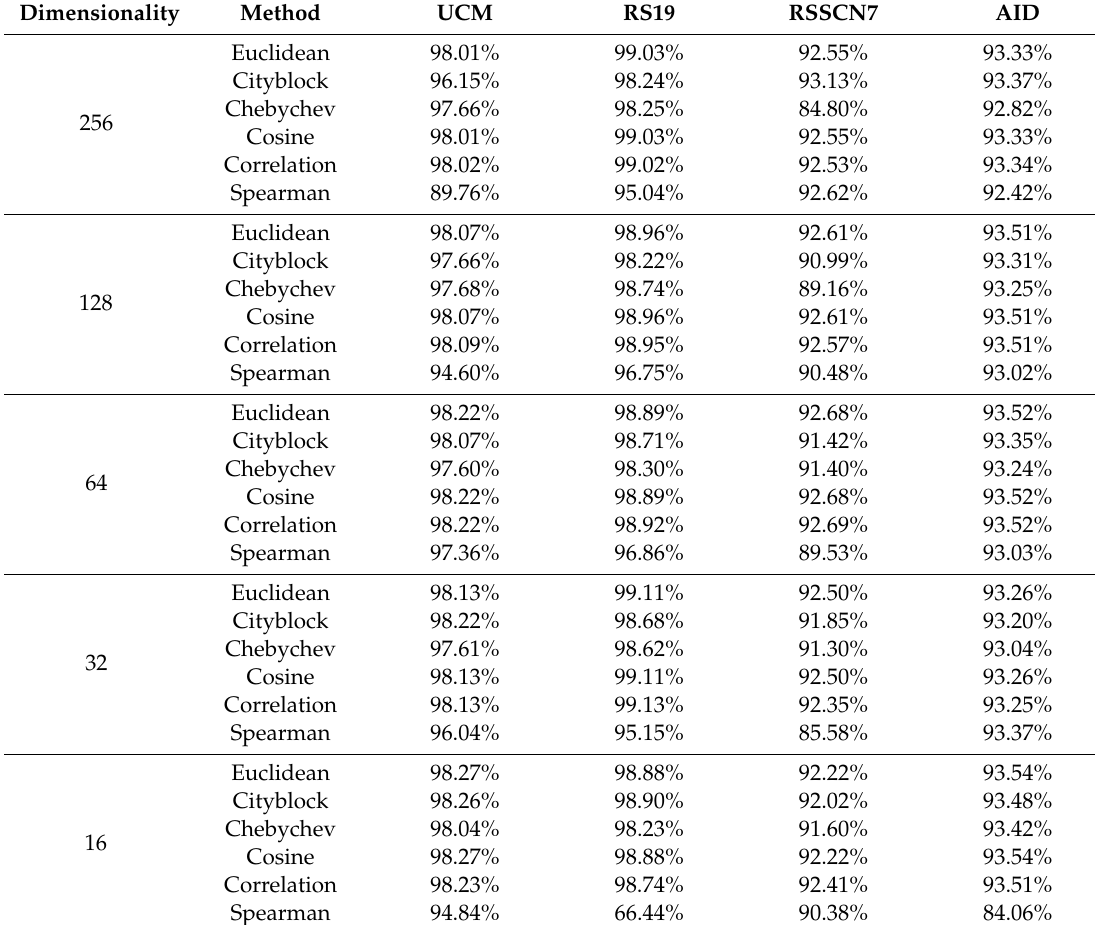
Table 4. Performance comparison of Euclidean distance and other similarity measurement methods.